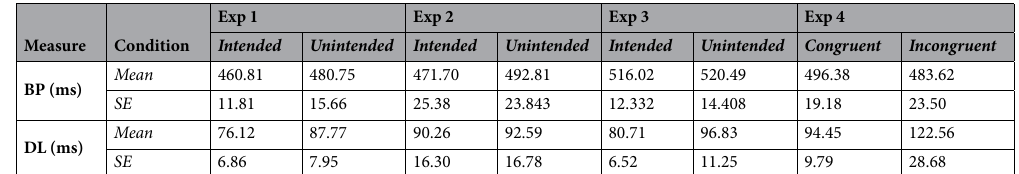
Table 1. The Mean and Standard error (SE) of the bisection point (BP) and Difference limen (DL) for all four experiments as a function of intention (Experiments 1–3) or stimulus congruency (Experiment